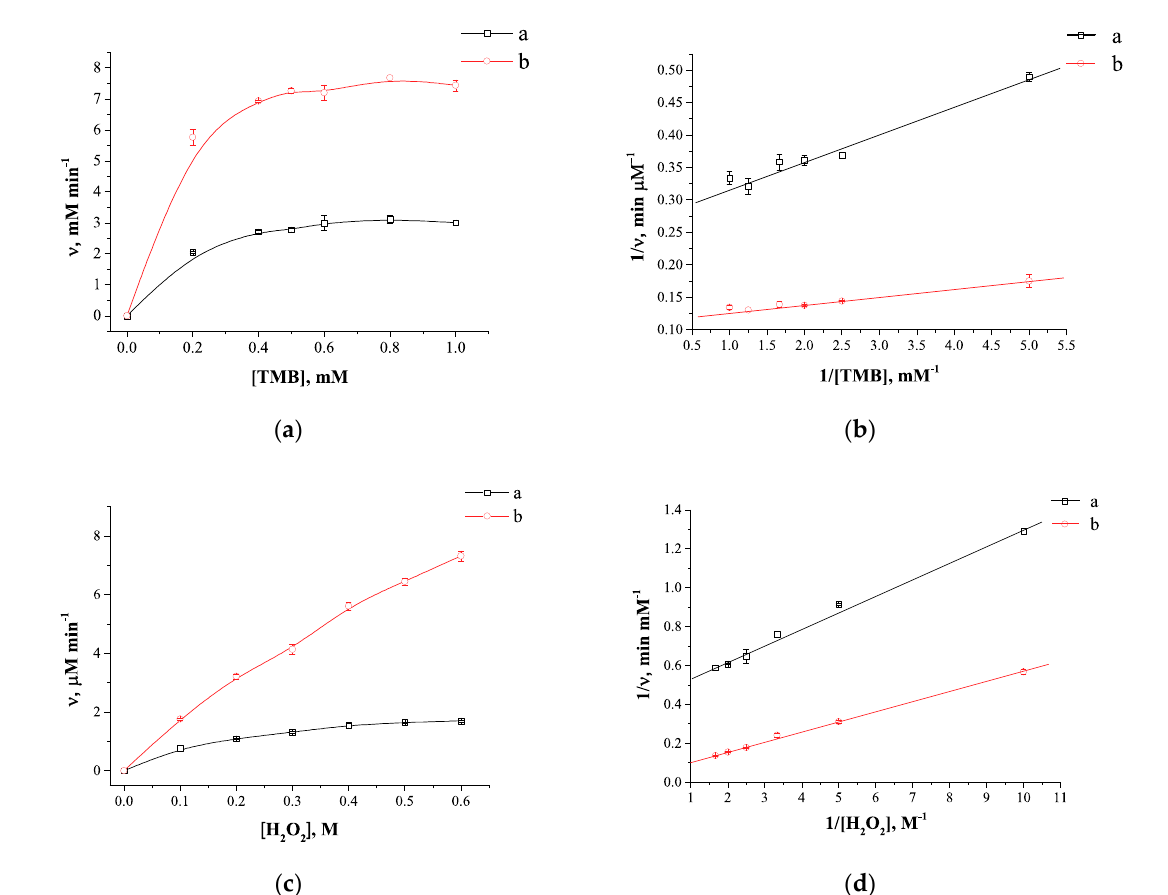
Figure 4. ( a ) Peroxidase-like activity of TA-capped AuNPs: a—substrate mixture, 0.5 M H 2 O 2 + 0.5 mM TMB; b—11.8 × 10 − 10 M TA-capped AuNPs + 0.5M H 2 O 2 + 0.5 mM TMB; c—11.8 × 10 − 10 M TA-capped AuNPs + 100 ng×mL − 1 Pb 2+ + 0.5 M